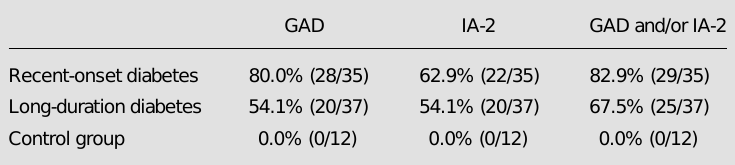
Table 2 - Prevalence of anti-glutamic acid decarboxylase (GAD) and ICA-512 (IA-2) antibodies in type 1 diabetes patients with recent-onset and long-duration diabetes (Fisher’s exact